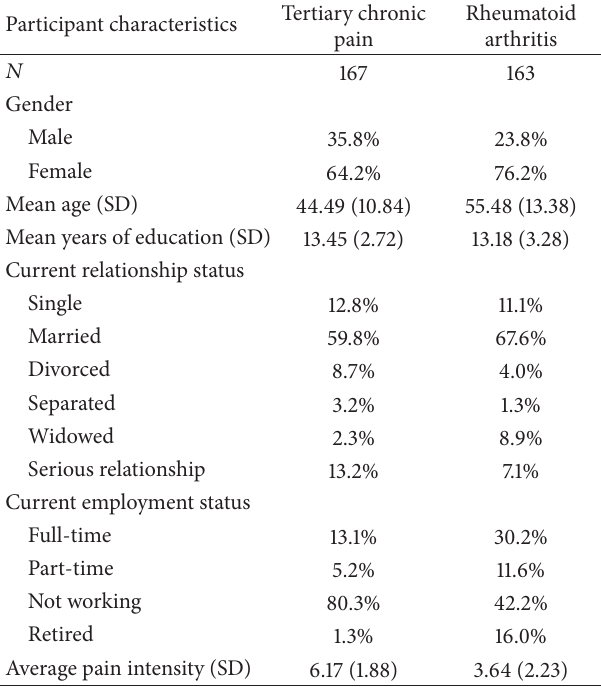
Table 1: Sample demographic